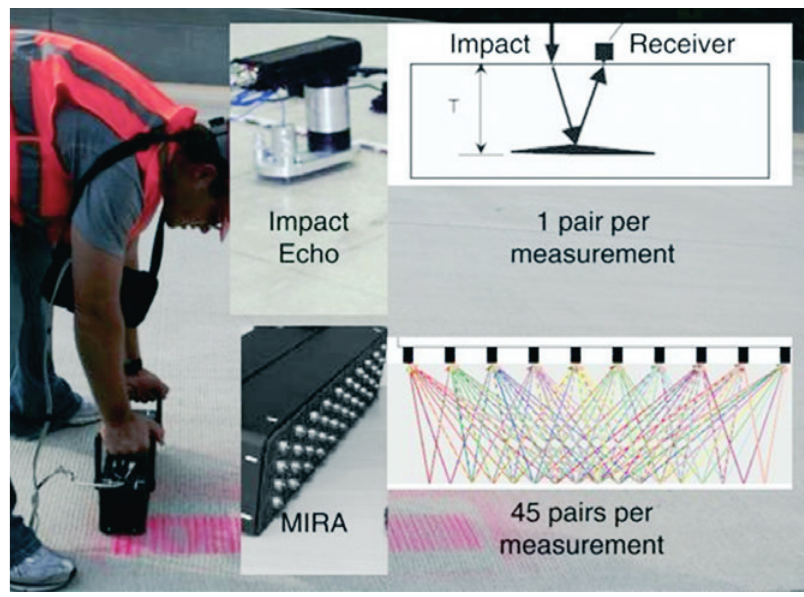
Impact echo versus MIRA (Hoegh et al. ,